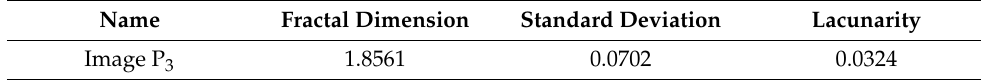
Table 3. Table 3. Calculation of fractal characteristics of picture P 3.